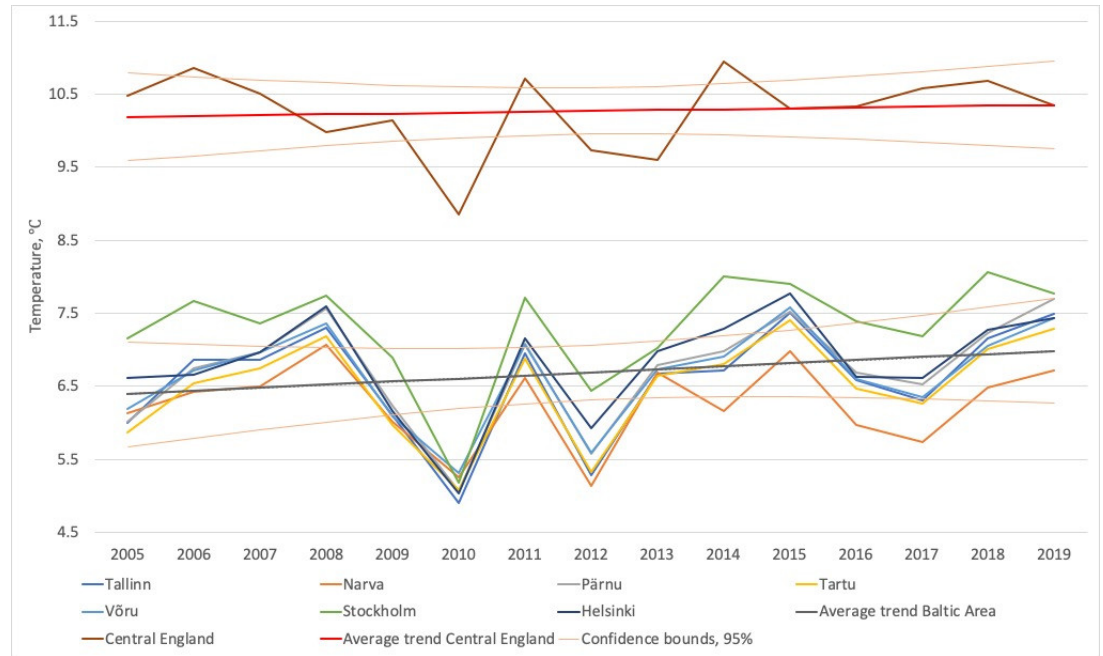
Figure 12. Changes in the average annual surface air temperatures from 2005 to 2019.